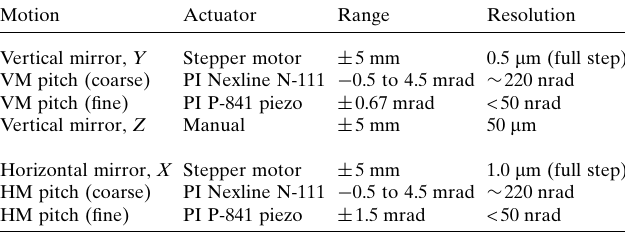
Table 2 Summary of motion actuators used in the KB-mirror assembly.